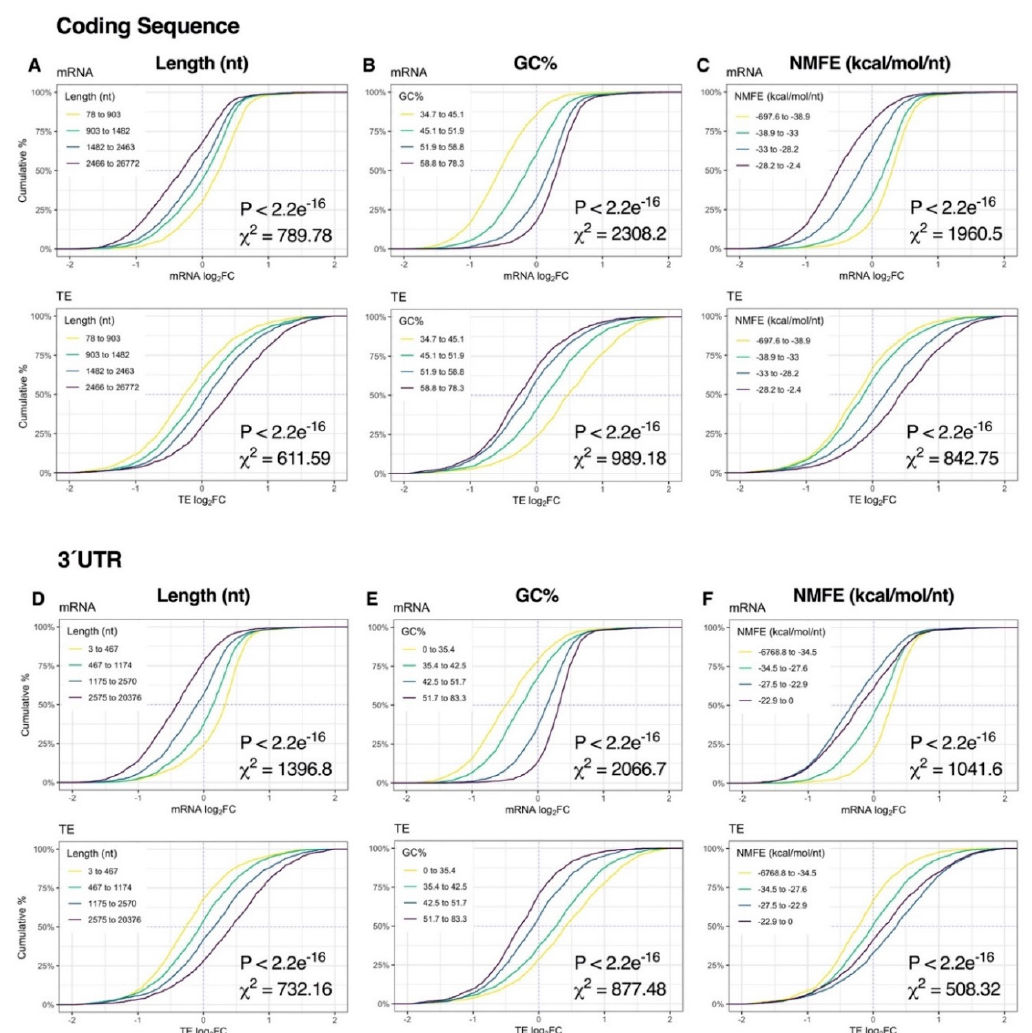
Figure 4. Relationship between mRNA dynamics and sequence features immediately after depolarization. ( A – C ) Cumulative density plots depicting changes in mRNA and translational efficiency (TE) log 2 FC after binning genes into quartiles by coding sequence length ( A ), GC% ( B ) or minimum free energy of secondary structures normalized to sequence length (NMFE) ( C ). All groups were compared via Kruskal–Wallis test, with associated p -values and Chi-squared ( χ 2 ) test statistics reported (bottom right). ( D – F ) As in ( A – C ), except examining the same features in the 3 (cid:48) untranslated region (UTR). See Supplementary Figure S5 for the full version with RPF data, Supplementary Figure S6 for 5 (cid:48) UTR data and Supplementary Figure S8 for G4, uAUG and rare codon frequency (RCF)